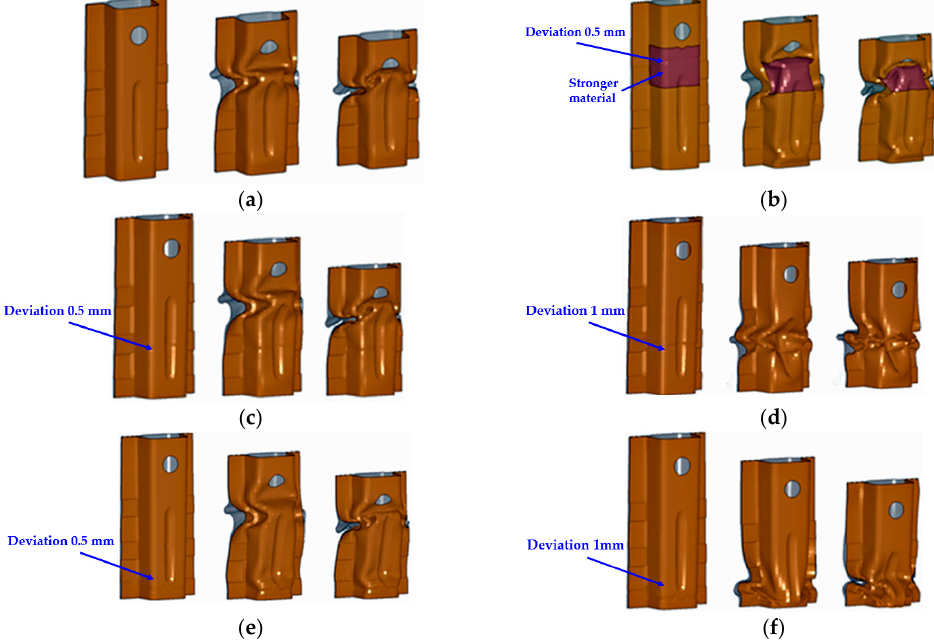
Figure 17. Initial shapes, 20 mm and 40 mm deformed specimen deformation shapes: model of the specimen of original characteristics ( a ); model simulating the specimen used during the repeated buckling experiment—material M1D in the first deformation wave range and with a geometric de- viation of 0.5 mm introduced ( b ); model of the specimen of original characteristics with 0.5 mm geometric deviation ( c ); model of the specimen of original characteristics with 1 mm geometric de- viation ( d ); model of the specimen of original characteristics with 0.5 mm geometric deviation in the bottom part of the specimen ( e ); model of the specimen of original characteristics with 1 mm geo- metric deviation in the bottom part of the specimen ( f ). The resulting deformation forces—axial specimen shortening diagrams—are similar in nature (Figure 18, curves (1) and (3)), and the formed first and second plastic defor- mation wave lengths remained unchanged.